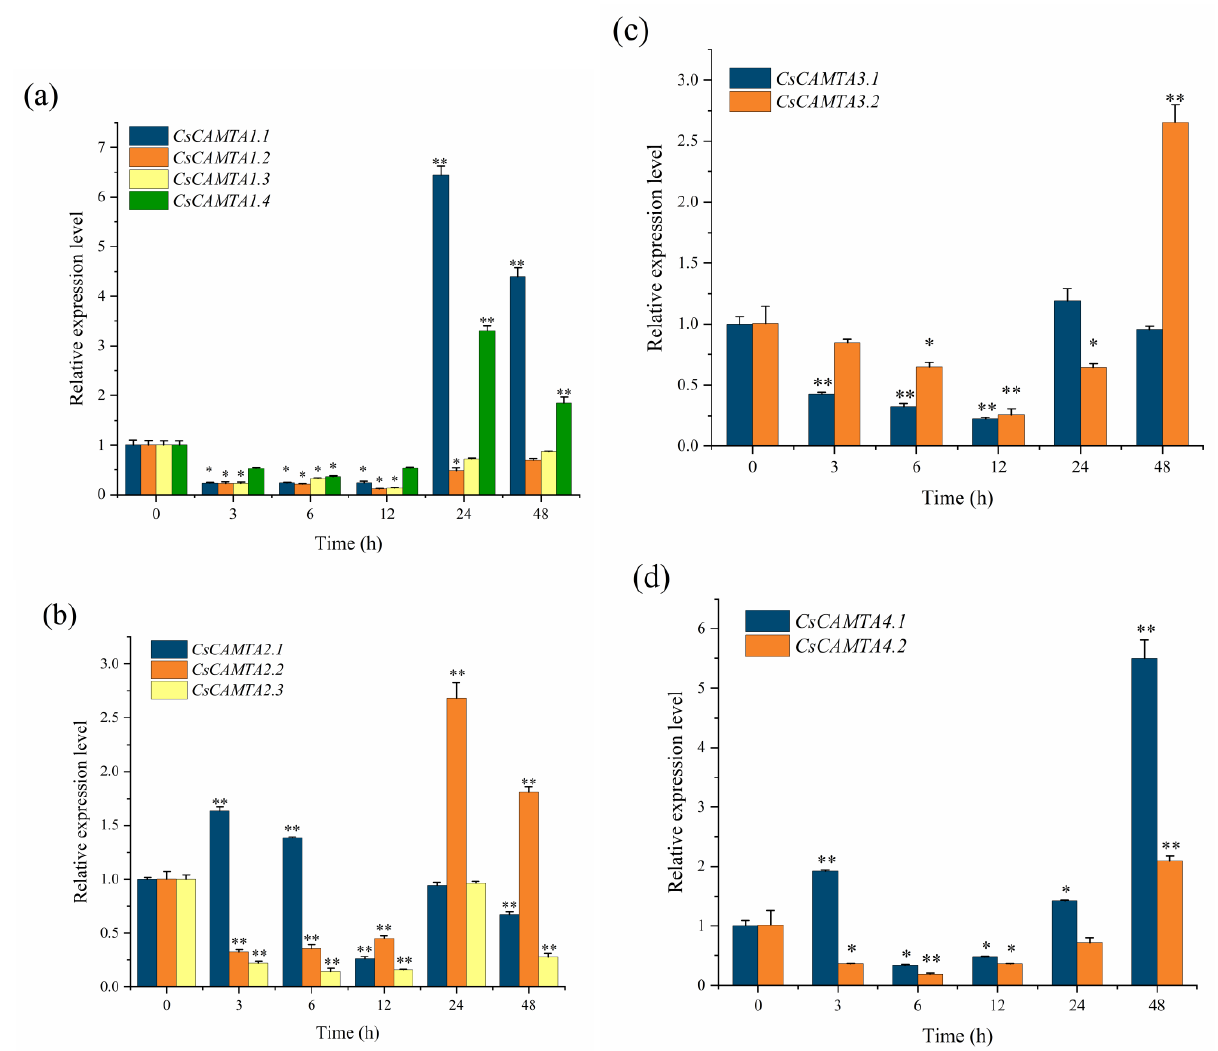
Figure 9. Expression analysis of alternative splicing form of CsCAMTA genes in leaves under drought stress. ( a ) CsCAMTA1 ; ( b ) CsCAMTA2 ; ( c ) CsCAMTA3 ; ( d ) CsCAMTA4 . Error bars represent the standard deviation of the three biological replicates. The asterisk (*) indicates that the expression level of the stress group is significantly different from that of the control group (* p < 0.05, ** p < 0.01, one-way ANOVA, Tukey test).